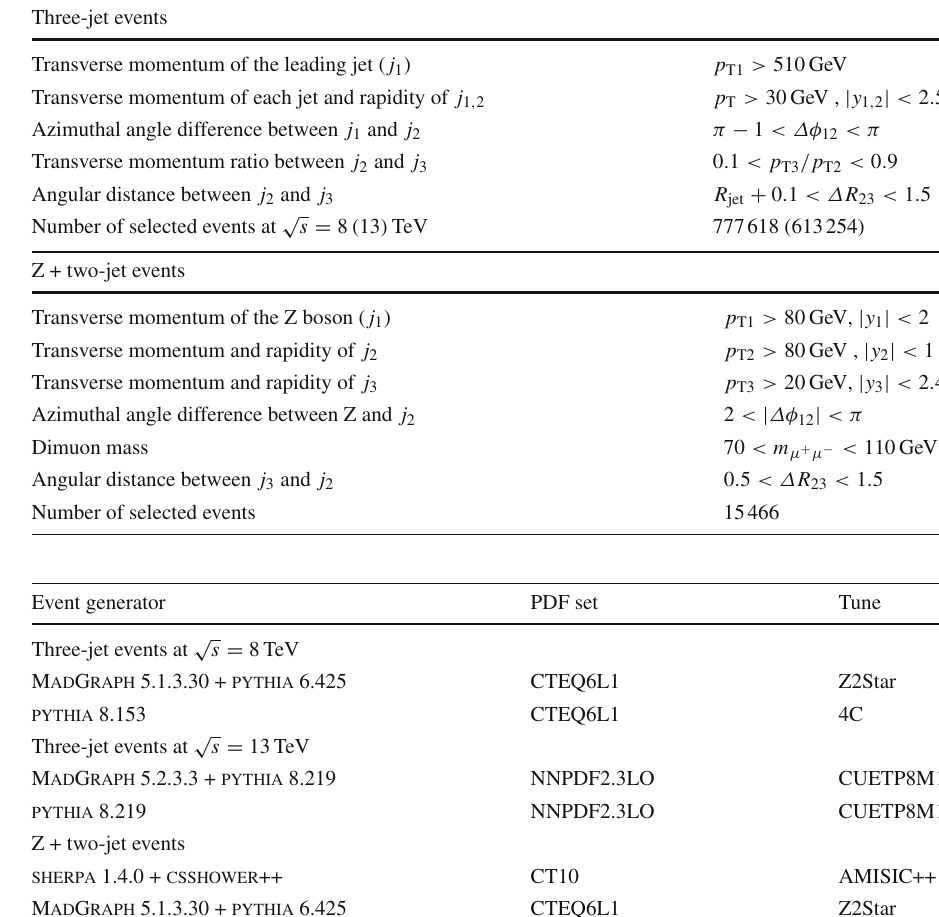
Table 1 Phase space selection for the three-jet and Z + two-jet analyses